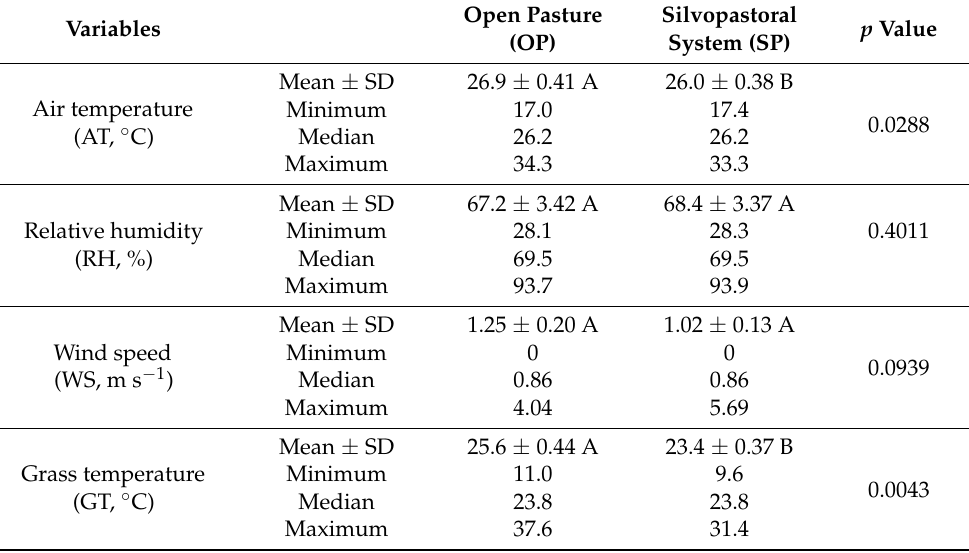
Table 1. Microclimatic variables between rearing systems throughout the summer (mean ± SD; median, maximum,